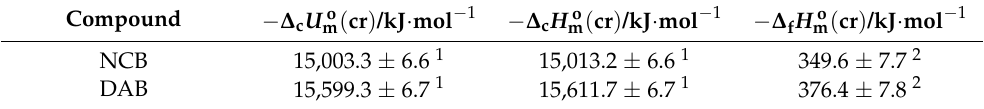
Table 2. Derived standard ( p ◦ = 0.1 MPa) molar values of compounds in the crystalline phase, at T = 298.15